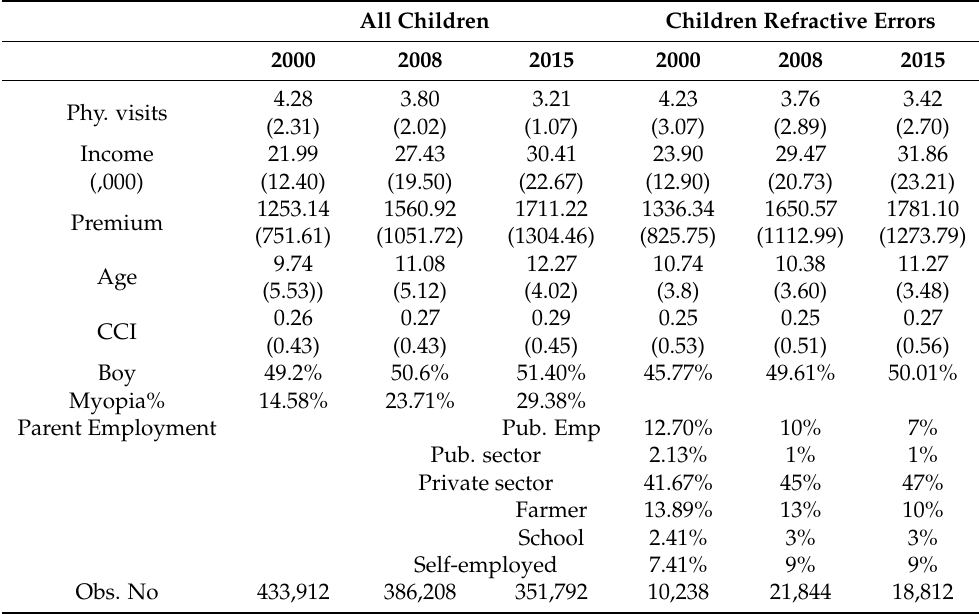
Table 1. Summary Statistics for All Children and Children with Refractive Errors. All